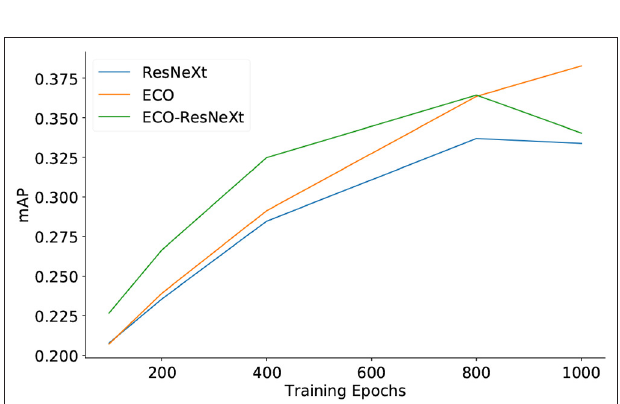
FIGURE 3 | The quality of semantic features predicted with different sets of input features evaluated by mAP on the YouTube2Text. “ResNeXt,” “ECO,” and “ECO-ResNeXt” denote that the semantic models are trained and the semantic features are predicted with visual features produced by ResNeXt, ECO, both ECO and ResNeXt, respectively.